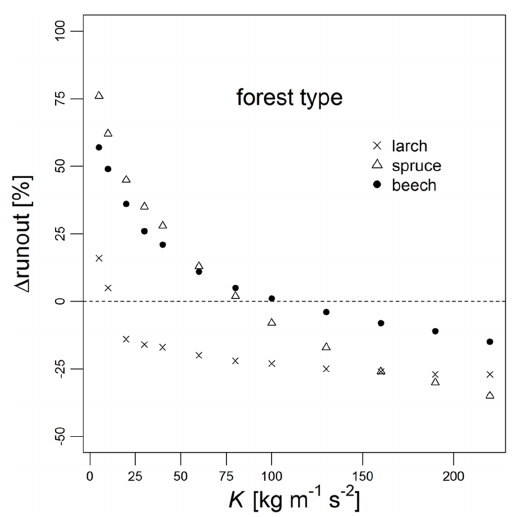
Figure 4. Mean values of 1 runout for each applied K value calcu- lated separately for the three forest type categories. The dashed line corresponds to 1 runout = 0 indicating the potential mean optimal K value for each